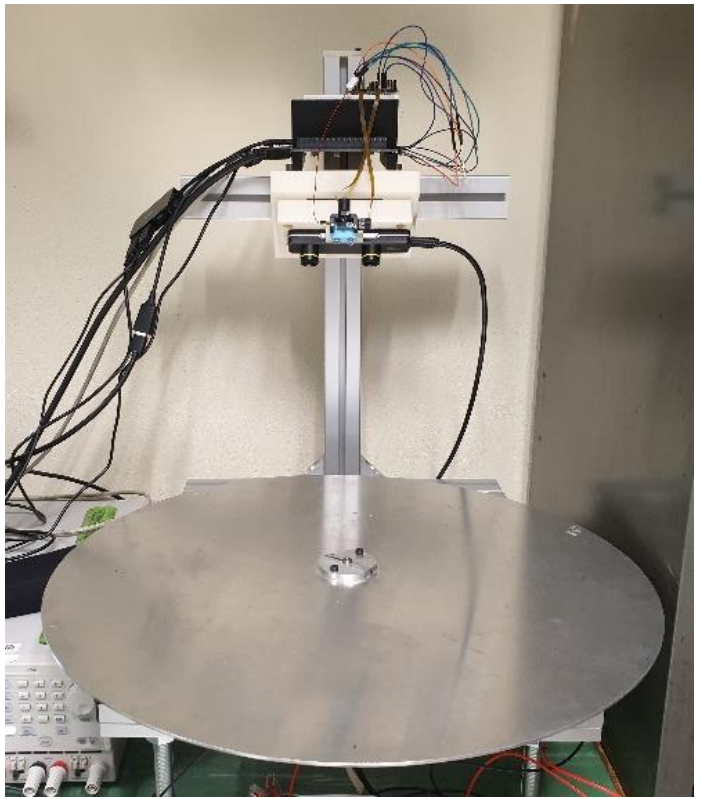
Figure 6. Visual servoing experimental